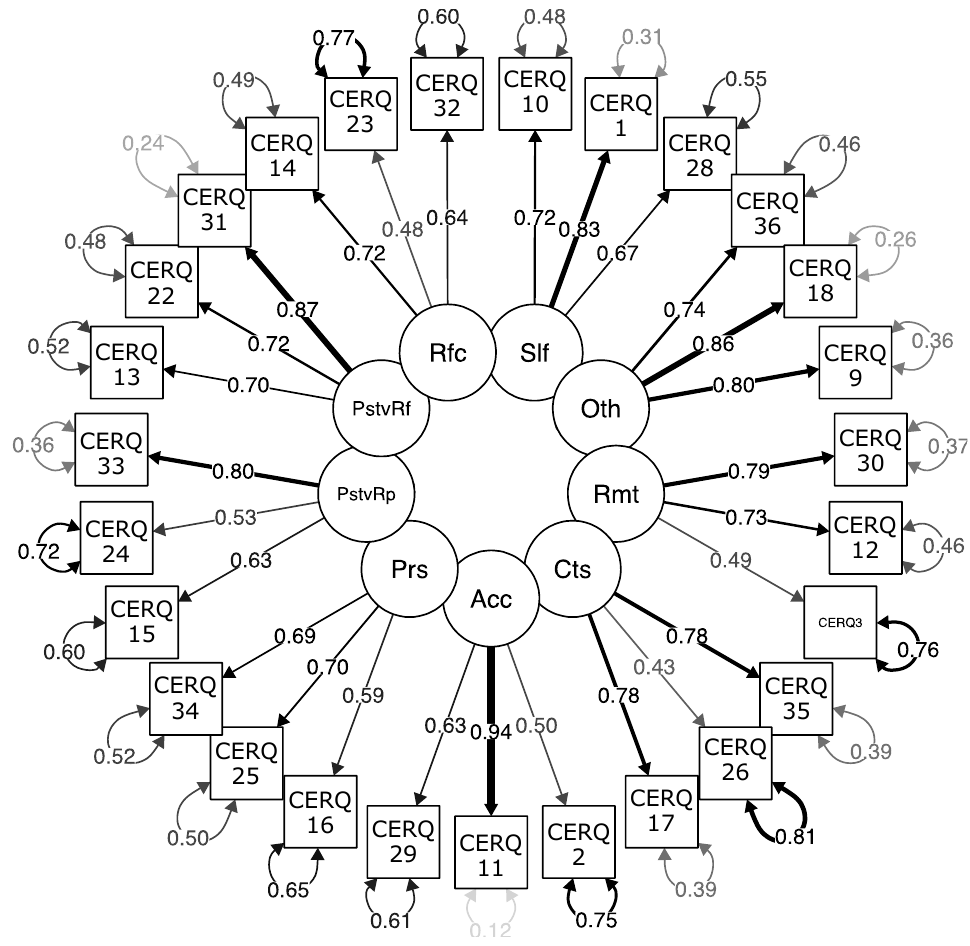
Figure 1. Measurement model with nine correlated factors and 27 items. Note: complete standard- ised model for the 27-item Spanish version of the Cognitive Emotion Regulation Questionnaire (CERQ-S-27; Model 3). Slf = Self-blame; Acc = Acceptance; Rmt = Rumination; PstvRf = Positive Refocusing; Rfc = Refocus on planning; PstvRp = Positive Reappraisal; Prs = Putting into perspective; Cts = Catastrophizing; Oth = Blaming others.